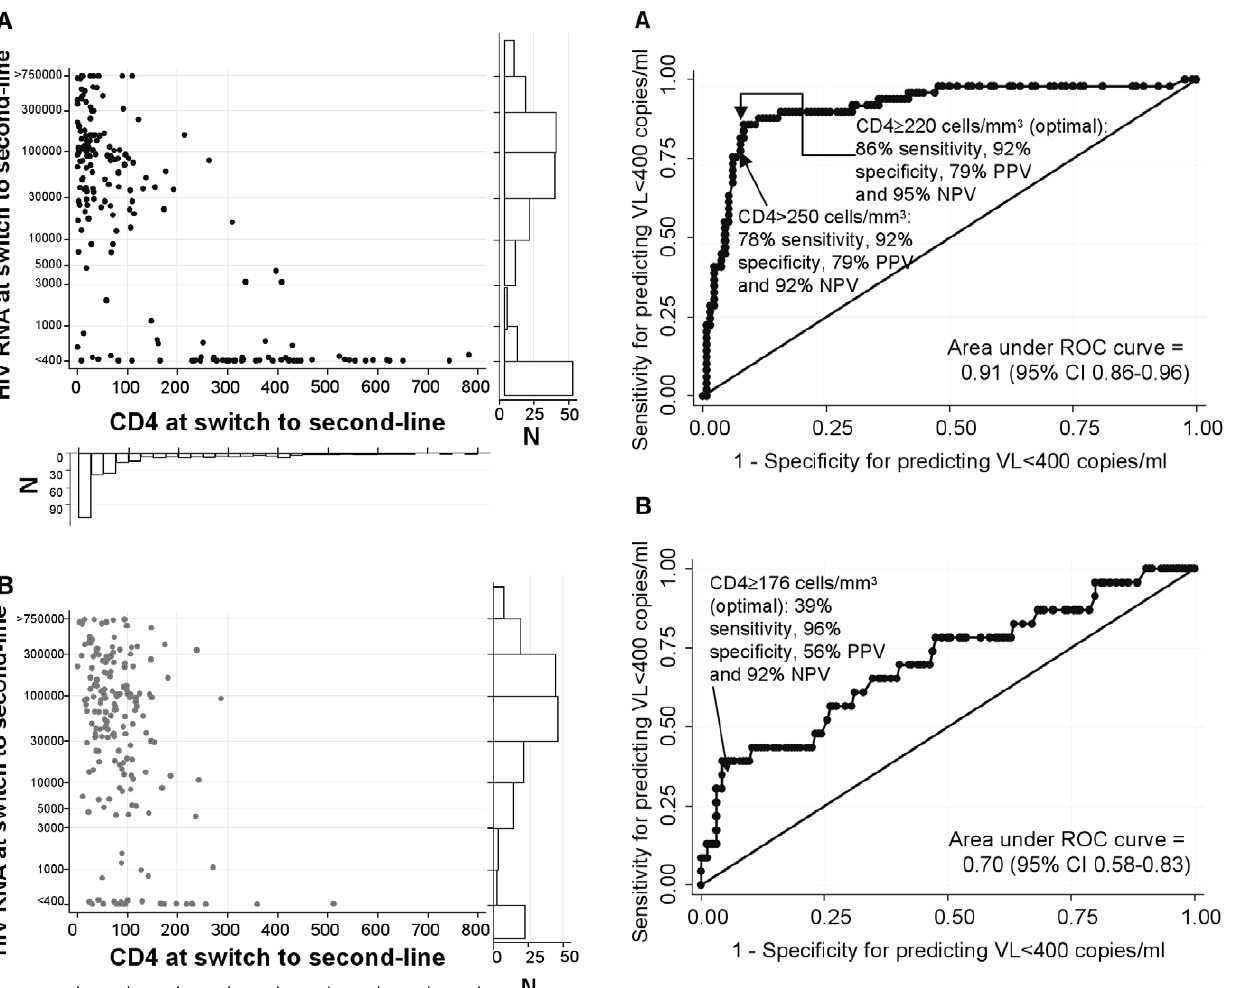
Figure 2. Ability of a single CD4 at switch to second-line for first-line failure to predict VL. (a) in patients not receiving routine CD4 count monitoring (CDM: 20% . 250 cells/mm3). (b) in patients receiving routine CD4 count monitoring (LCM: 2% . 250 cells/mm3). Footnote 2 Receiver operator curves (ROC) show how the sensitivity and specificity of CD4 thresholds for predicting VL , 400 copies/ml varies as CD4 increases from 1 to 788 (CDM) or 505 (LCM) cells/mm 3 . The straight line indicates performance no better than chance. The threshold with the greatest probability of correctly classifying each CD4 count according to whether it has VL , 400 copies/ml or not is indicated with sensitivity (proportion with VL , 400 c/ml who have CD4 $ thres- hold), specificity (proportion with VL $ 400 c/ml who have CD4 , threshold), positive predictive value (proportion of patients with CD4 $ threshold who have VL , 400 c/ml) and negative predictive value (proportion of patients with CD4 , threshold who have VL $ 400 c/ml).